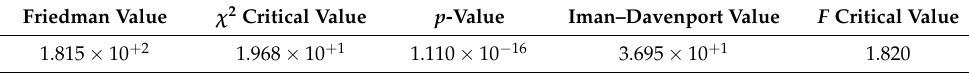
Table 13. Friedman and Iman–Davenport statistical test results summary ( α = 0.05). Friedman